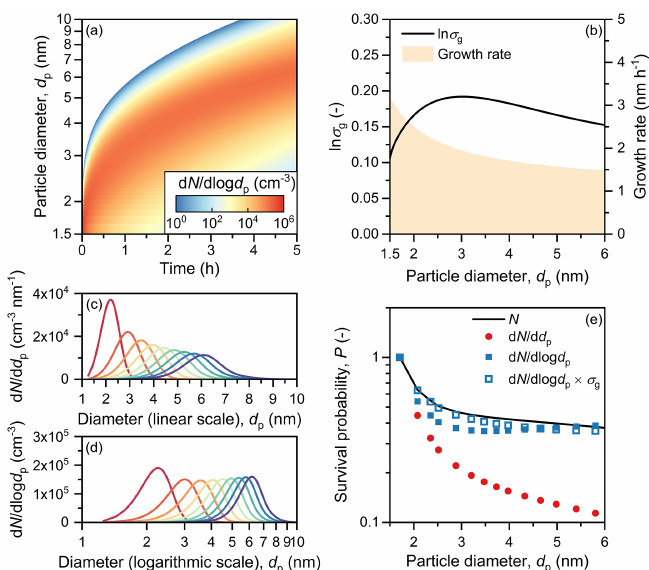
Figure A3. The growth of particles driven by the condensation of a volatile vapor and particle coagulation. The simulation inputs are the same as those in Fig. A2 except that the vapor dissociation rate is assumed to be 50% of the association rate, and particle coagulation is accounted for in this simulation. This figure shows that evaporation and coagulation can lead to a broadening in d N/ d d p on the linear scale. Although σ g is relatively constant for this simulation, it can have a strong size dependency for other simulation conditions. Hence, it is important to check σ g before using Eq. (6) to compute the survival